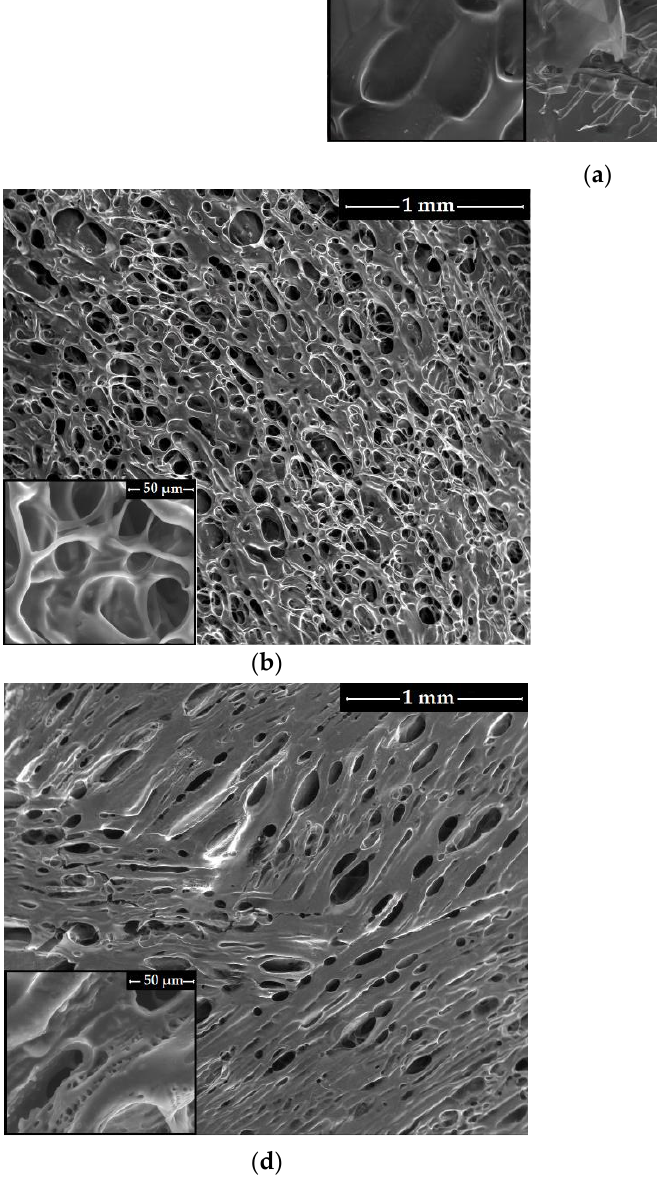
Figure 3. SEM images on the surface of non-charged chitosan membranes: ( a ) CS-A, ( b ) CS-SA/DS-1 and ( c ) CS-SA/DS-2 and of the lidocaine-charged membranes: ( d ) CS-SA/DS-1-LID and ( e ) CS-SA/DS-2-LID.